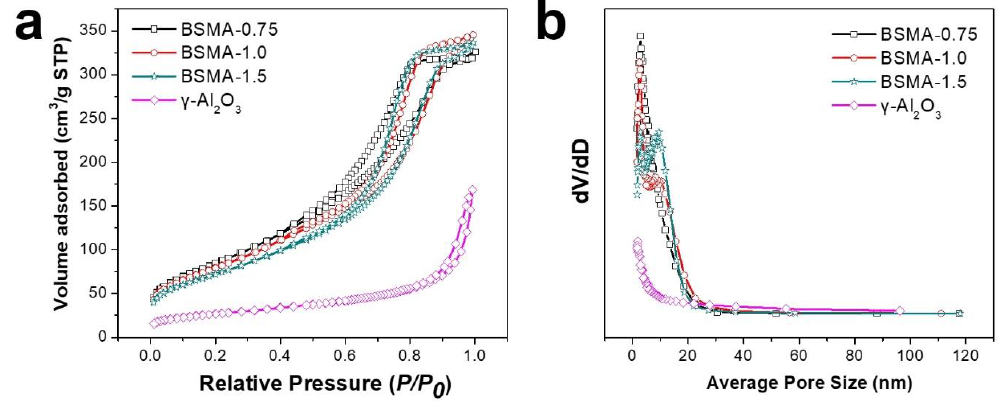
Figure 5. ( a ) N 2 isotherm and ( b ) BJH pore size distribution of commercial γ -Al 2 O 3 and BSMA